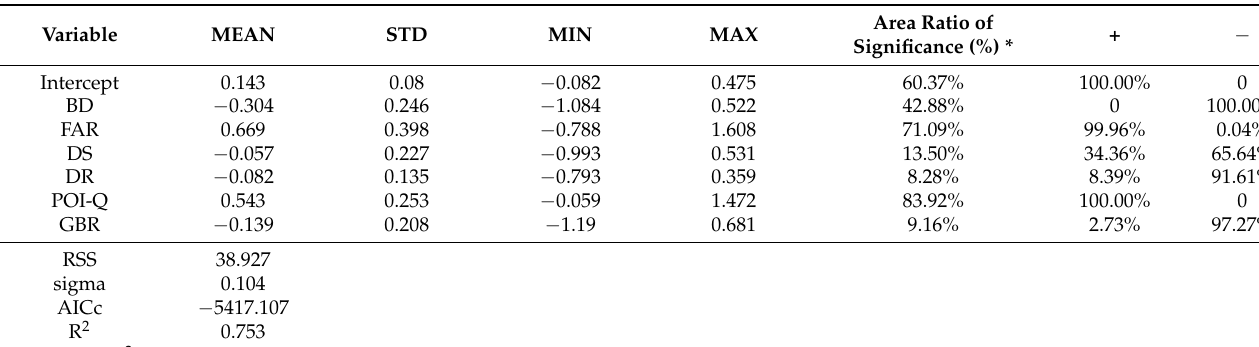
Table 2. The GWR model results for the epidemic